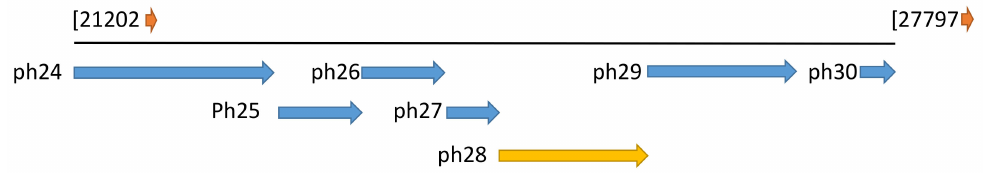
Figure 1. Genomic context of the ph28 gene in the Staphylococcus phage PH15 (accession